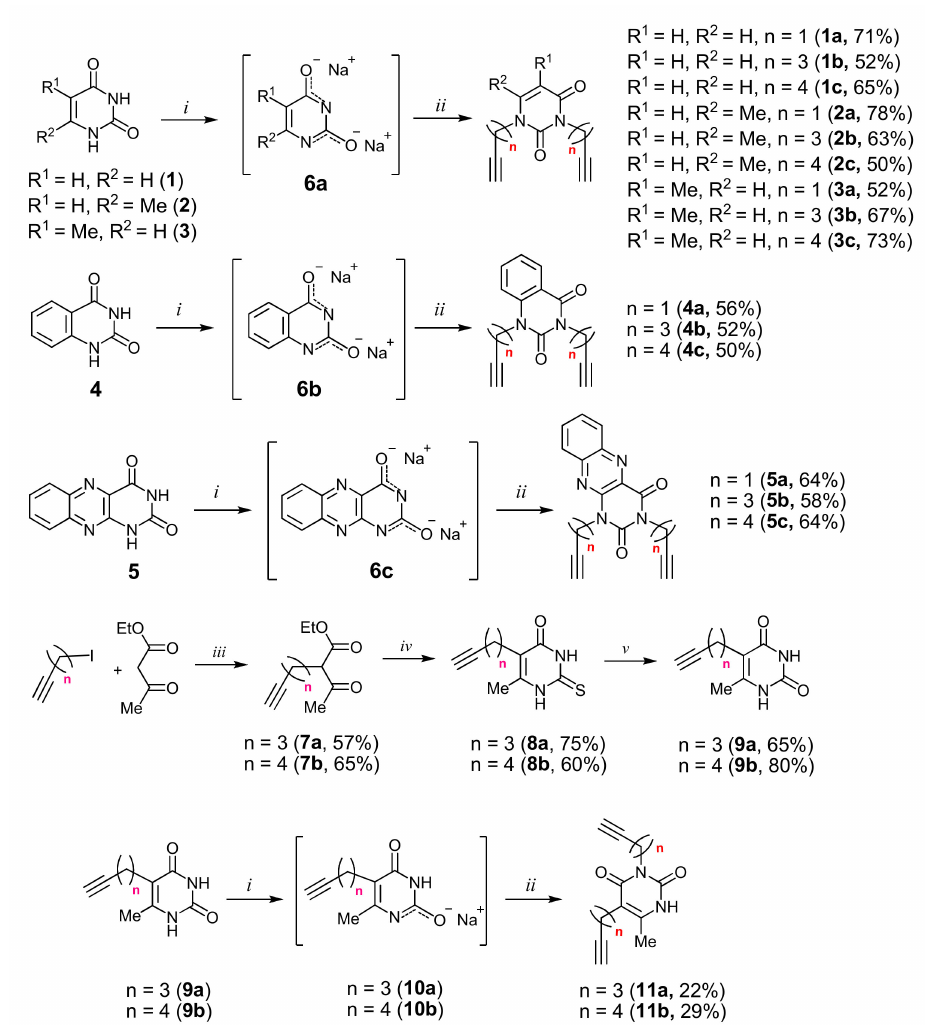
Scheme 1. Synthesis of 1,3- and 3,5-bis( α , ω -alkinyl)pyrimidines. Reagents and conditions: ( i ) NaH, DMF, 67–70 ◦ C, 8 h; ( ii